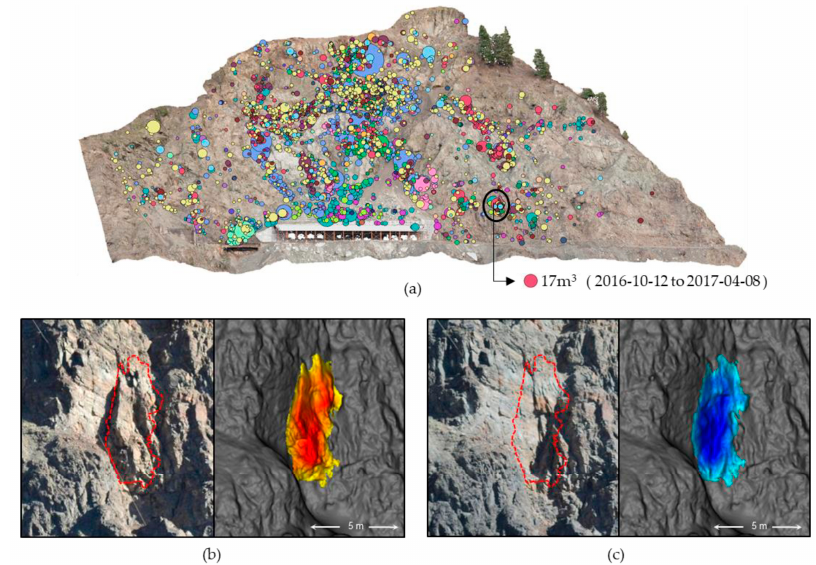
Figure 16. A 16.7 m 3 rockfall occurred at interbeds between the argillite and sandy siltstone layers, displayed in gigapixel photographs and in TLS data. ( a ) Rockfall data with the area of interest circled; ( b ) Pre-failure photograph and surface model overlaid with the outline of the post failure rockfall boundary; ( c ) Post-failure identification of the rockfall back